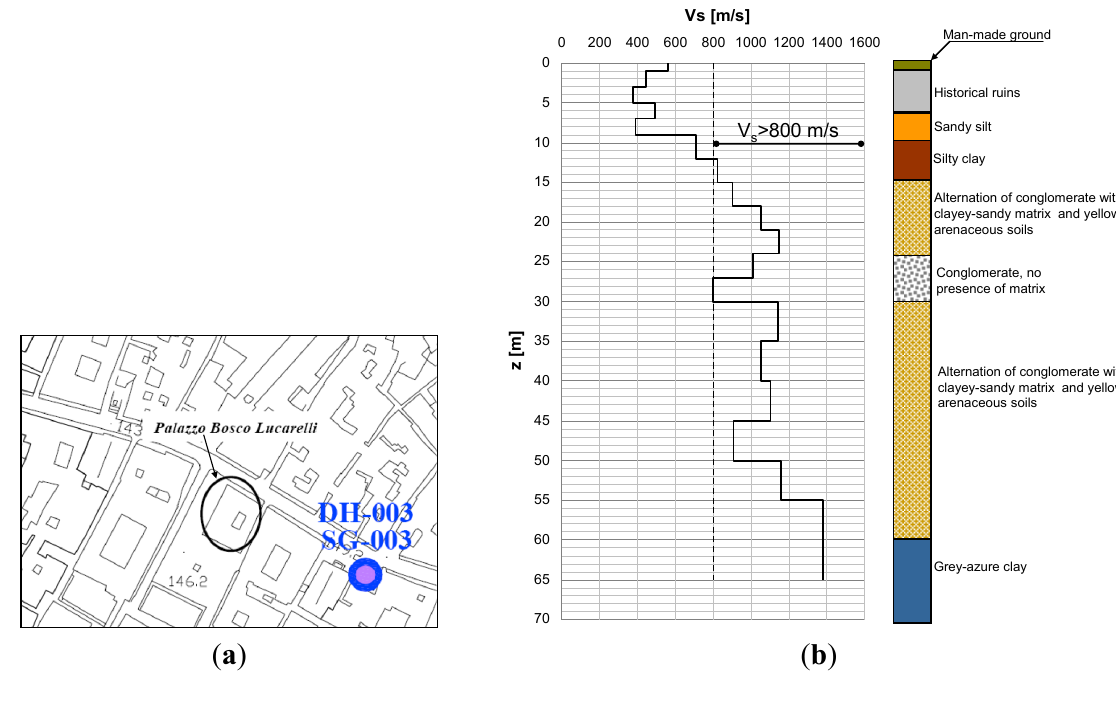
Figure 4. ( a ) Location of the boreholes and down-hole (DH) test; ( b ) shear wave velocity vs. depth measured by DH